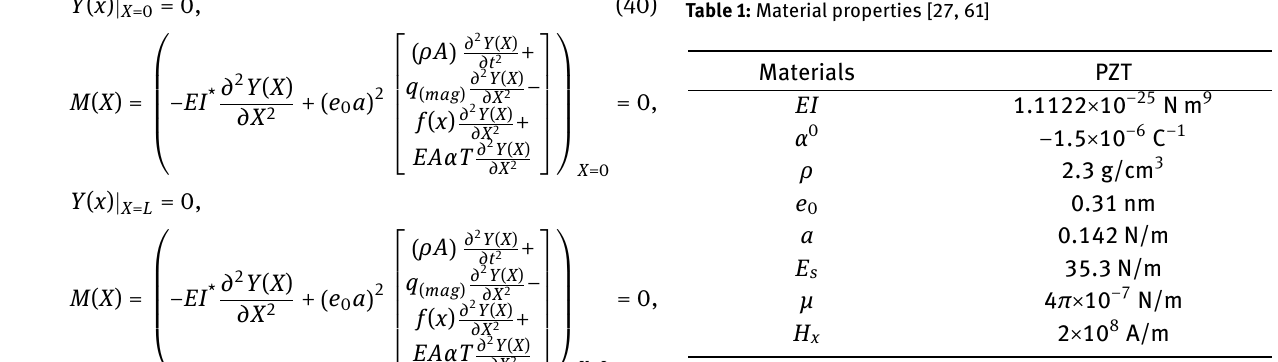
Table 1: Material properties [27,